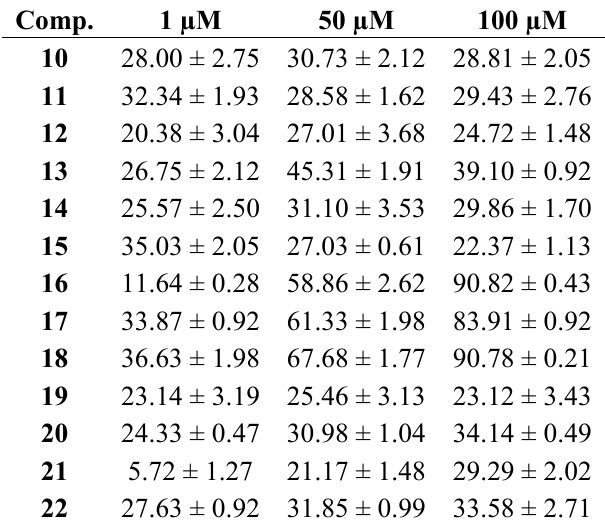
Table 2. Inhibitory effects (%) a of compounds 10 – 22 on U937 cell viability (mean ± SD; n = 4). Comp.